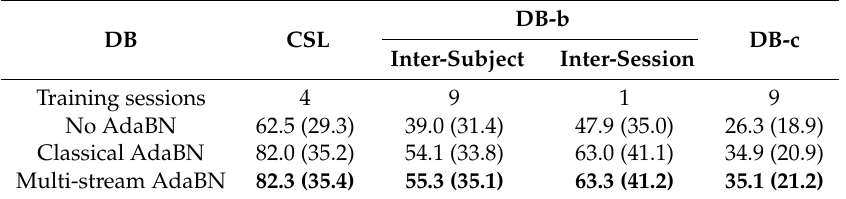
Table 7. Recognition accuracies (%) of inter-session evaluation with different adaptation methods. The numbers are majority voted results using entire trial for CSL-HDEMG and 150 ms window (i.e., 150 frames) for CapgMyo, respectively. Per-frame accuracies are shown in parentheses.